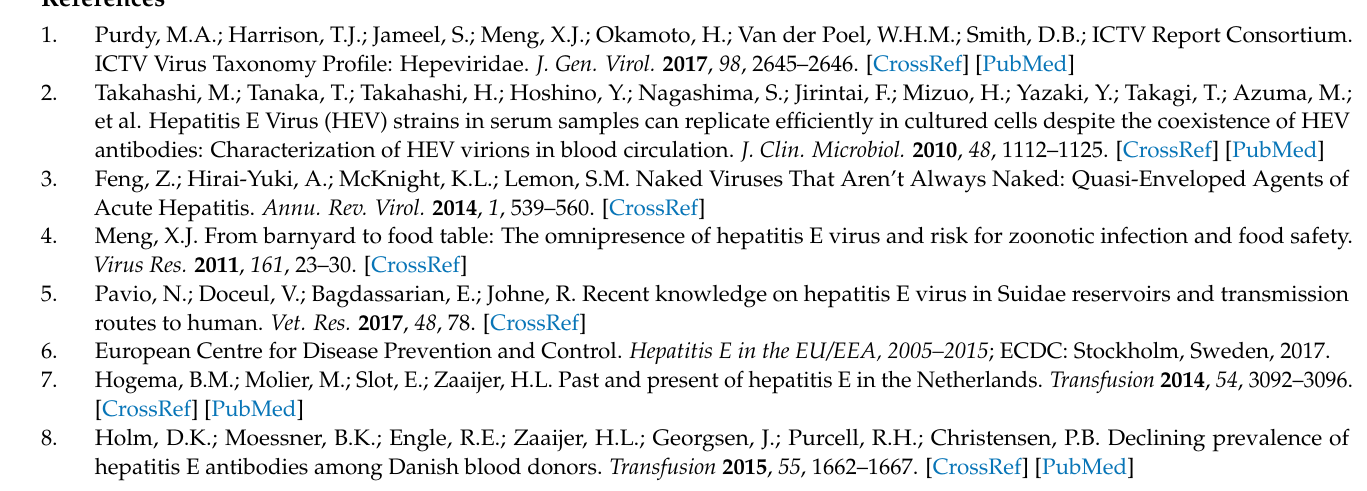
Figure S2: Pairwise identities, Table S1: Different sample types: farms; Table S2: Sock